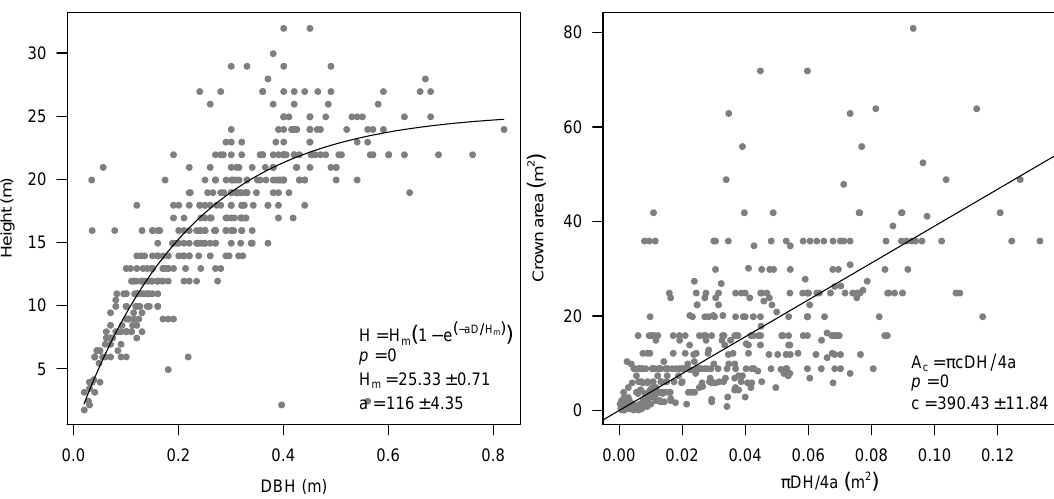
Figure 2. Estimation of parameter values for the application of the T model. Diameter at breast height ( D ), tree height ( H ), and crown area ( A c ) of the 400 trees from the sample plots were used for the estimation of the initial slope of the height–diameter relationship ( a ) and (asymptotic) maximum tree height ( H m ). Relationships among crown area ( A c ), diameter at breast height ( D ), and height ( H ) (Eq. 7) are used to estimate the initial ratio of crown area to stem cross-sectional area ( c